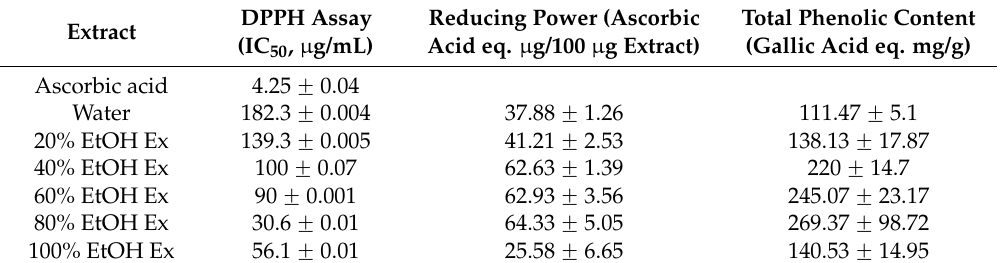
Table 6. Antioxidant activity and total phenolic contents of extracts of C. coreana flos. DPPH Assay Reducing Power Extract (IC 50 , µ g/mL)